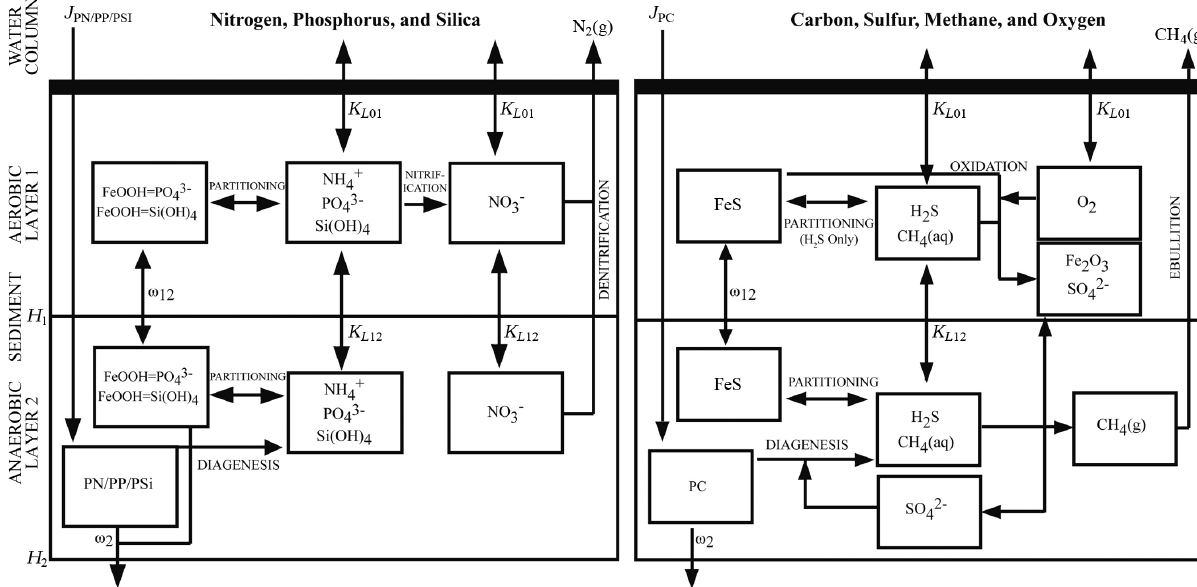
Fig. 2. Flow diagram illustrating the state variables, transport processes, and reactions in the sediment flux model, including those for nitrogen, phosphorus, and silica (left panel) and carbon, sulfur, methane, and oxygen (right panel). PN, PC, PSi, and PP are particulate nitrogen, carbon, silica, and phosphorus, respectively, and ω 12 is the particle mixing rate between layers 1 and 2. Please refer to ‘Materials and methods: sediment biochemical modeling’ for parameter